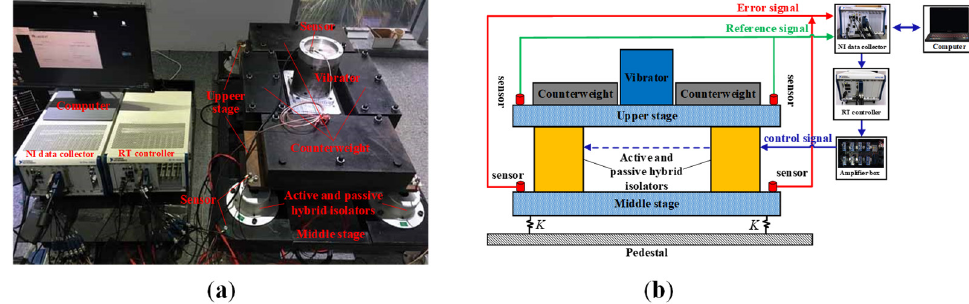
Figure 9. The prototype of the two-DOF hybrid vibration isolation system: ( a ) physical diagram; ( b ) schematic diagram.